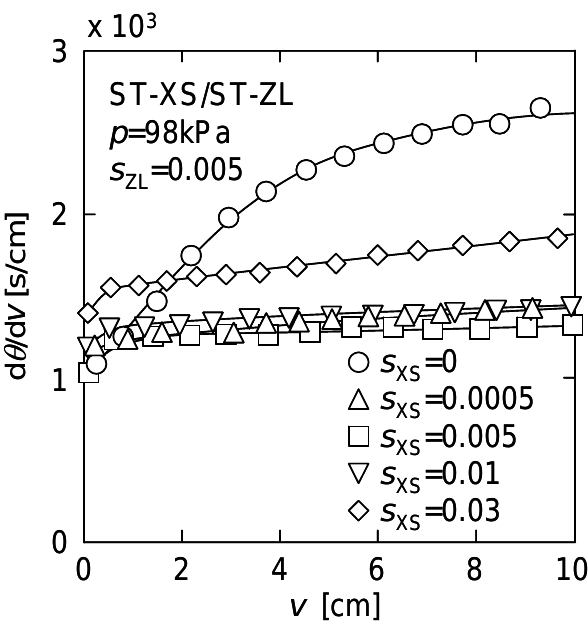
Figure 9. Effect of small particle concentration on filtration behavior in upward UF.